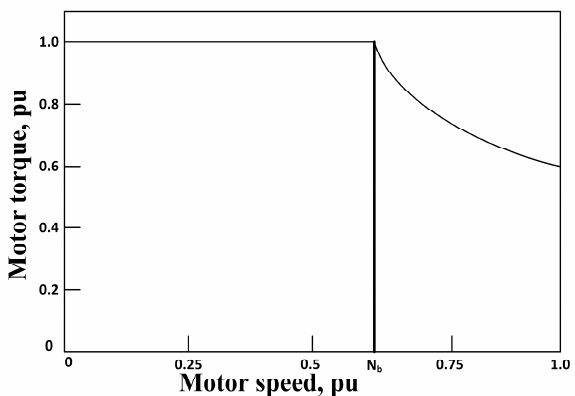
Figure 35. Characteristics of a Permanent Magnet Brushless DC Motor. The torque remains constant at the maximum right from the start, but starts to decrease exponentially for speeds over the base